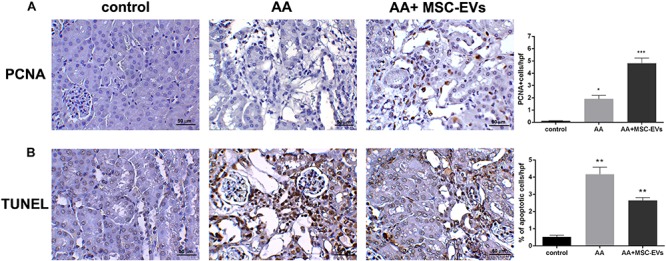
Representative micrographs of PCNA and TUNEL stained renal tissue. (A) Proliferating cell nuclear antigen (PCNA) staining of control, AA, or AA mice treated with MSC-EVs. Histological score of PCNA positive cells in AAN mice experimental groups observed under high power with an original magnification of 400X. An increase in PCNA positive cells was observed in MSC-EV treated mice renal tissue. Data represent mean ± SEM. A one way ANOVA with Bonferroni’s multi comparison test was performed. *p < 0.01 AA vs. control, or ***p < 0.05 AA+MSC−EVs vs. AA (B) TUNEL staining of control, AA, or AA mice treated with MSC-EVs. Histological score of% of apoptotic cells (by TUNEL staining) in AAN mice experimental groups observed under high power with an original magnification of 400X. A decrease in TUNEL positive cells was observed in MSC-EV treated mice renal tissue. Data represent mean ± SEM. A one way ANOVA with Bonferroni’s multi comparison test was performed. **p < 0.01 AA vs. control, or **p < 0.05 AA+MSC−EVs vs. AA. Original magnification at 400X.